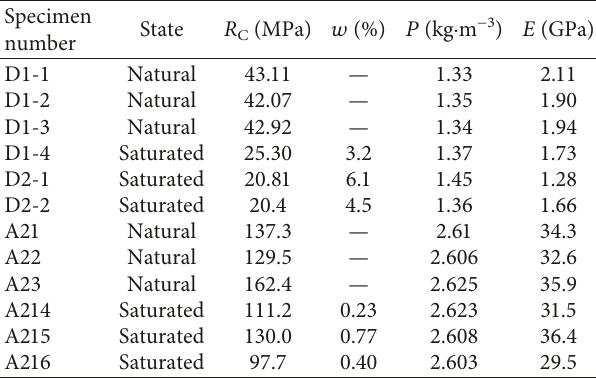
Figure 4: Dynamic stress-strain curves for coal specimens with different moisture states. (a) Natural state. (b) Water-saturated state. Table 1: Physicomechanical parameters of natural and water- saturated specimens under uniaxial